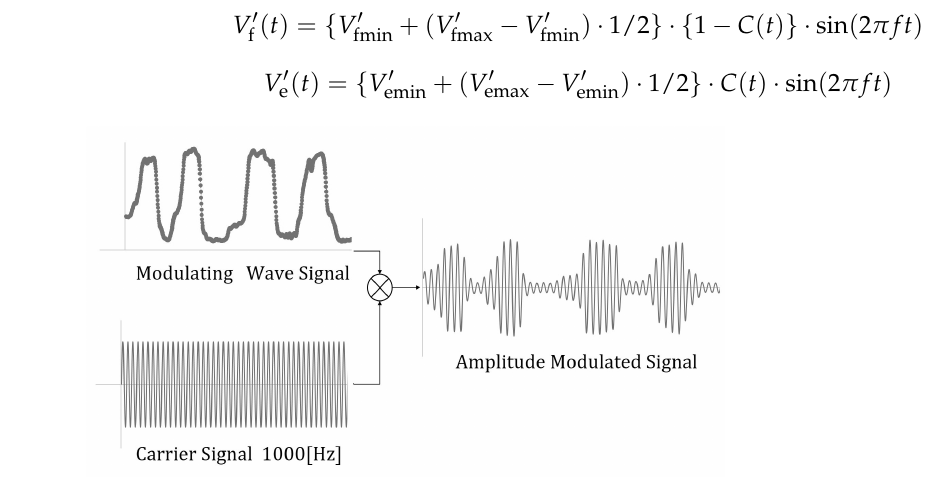
Figure 2. Signal processing